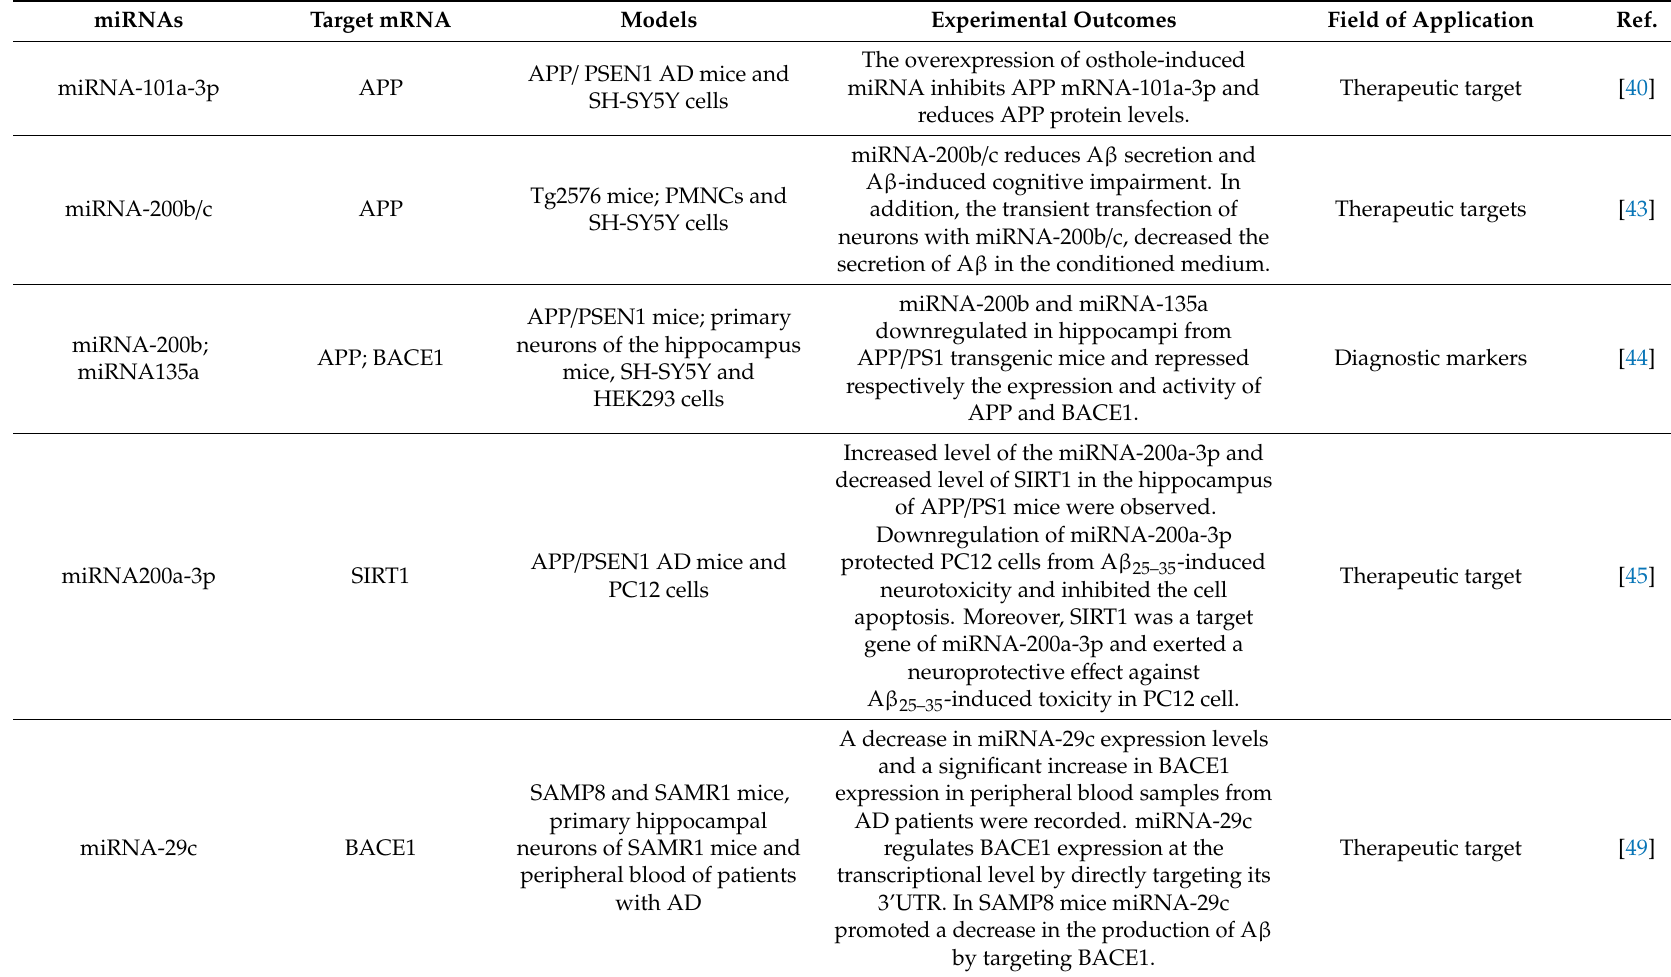
Table 1. A summary of microRNAs (miRNAs) linked to Alzheimer’s disease